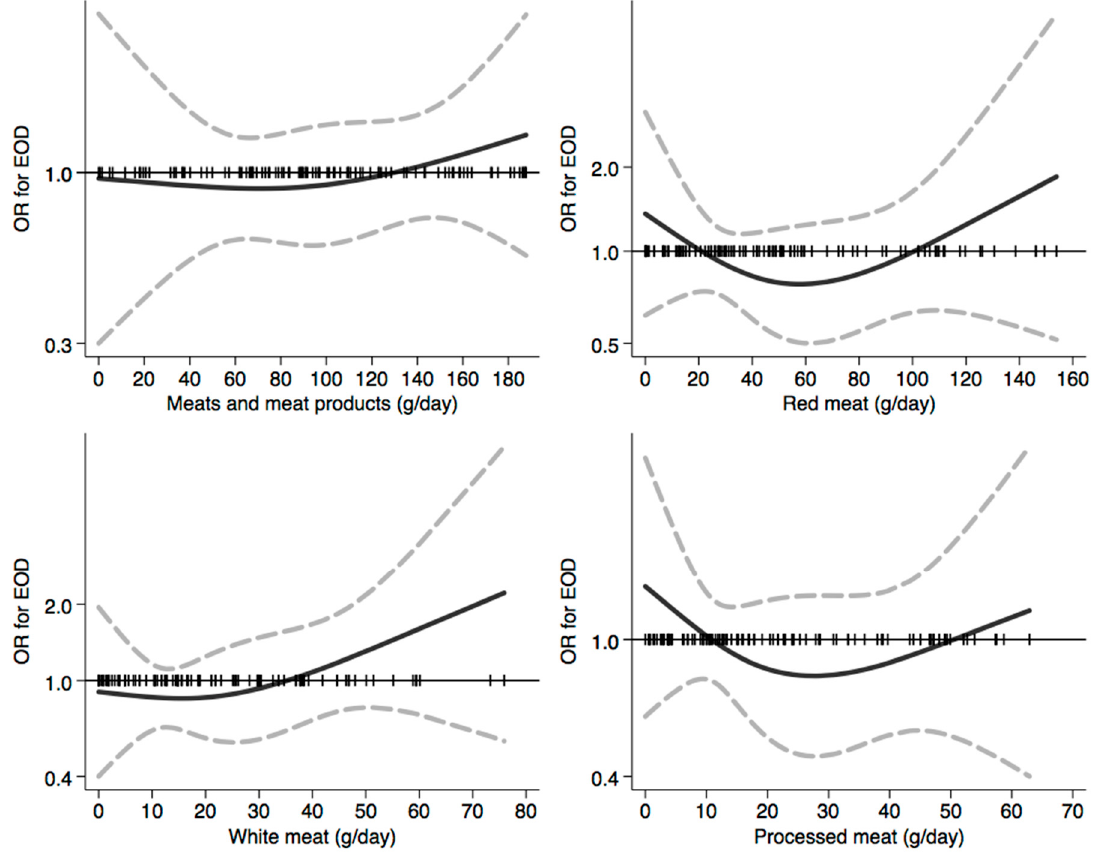
Figure 2. Spline regression analysis of early ‐ onset dementia (EOD) risk for increasing intake of meats and meat products. The black line indicates odds ratios for dementia risk; dash gray lines are 95% confidence limits; the reference line at 1.0 with black spikes indicates the distribution of participant intake. Note: spline analysis was not possible for offal due to a few subjects reporting consumption which is different from a null value.